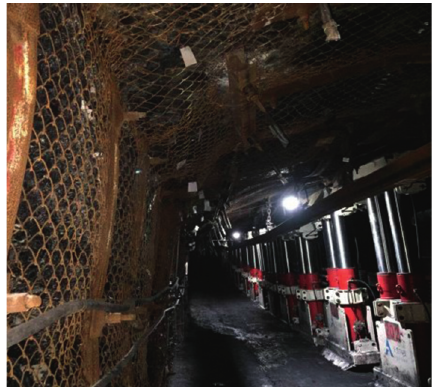
Figure 10: Effect diagram of roadway retaining support.